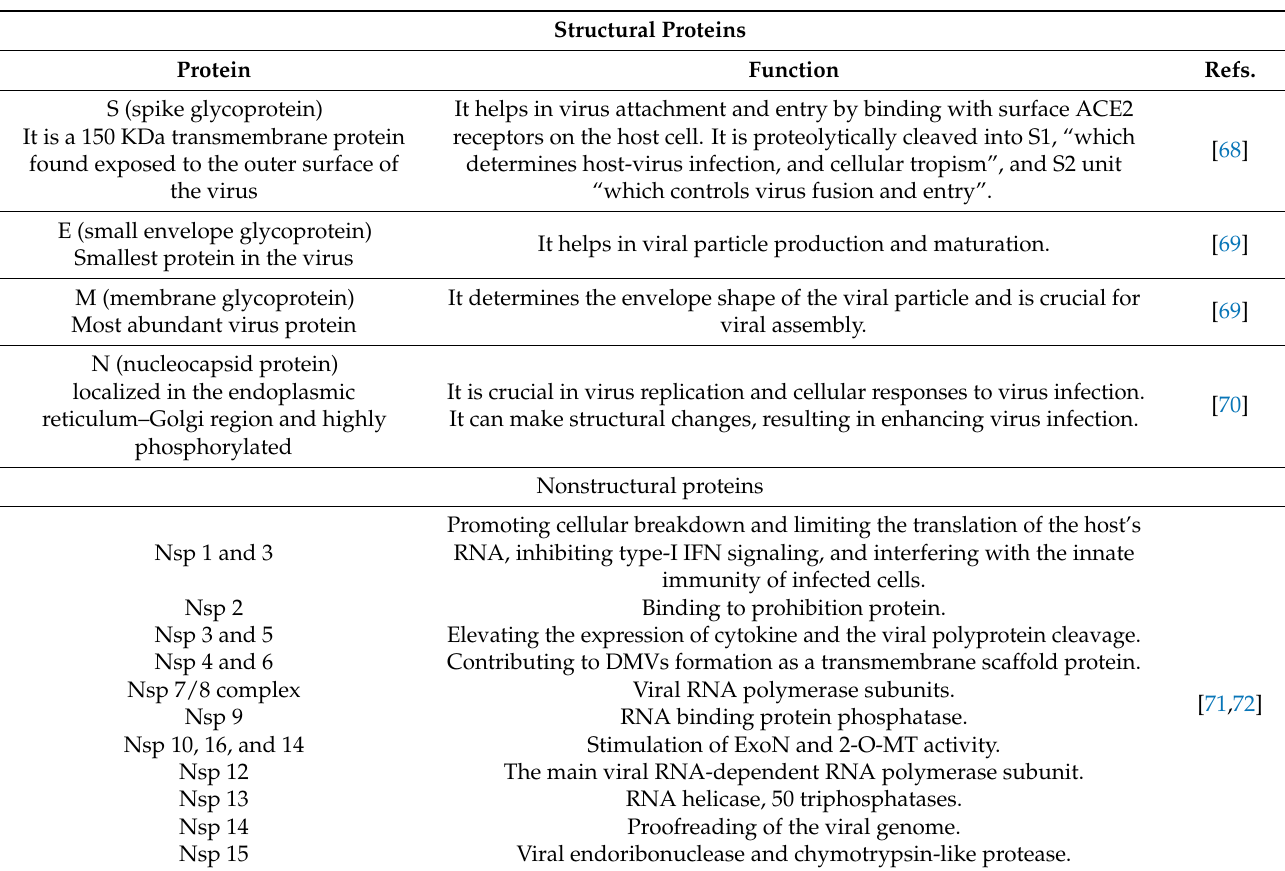
Table 1. Structural and nonstructural proteins of SARS-CoV-2 and their functions. Structural